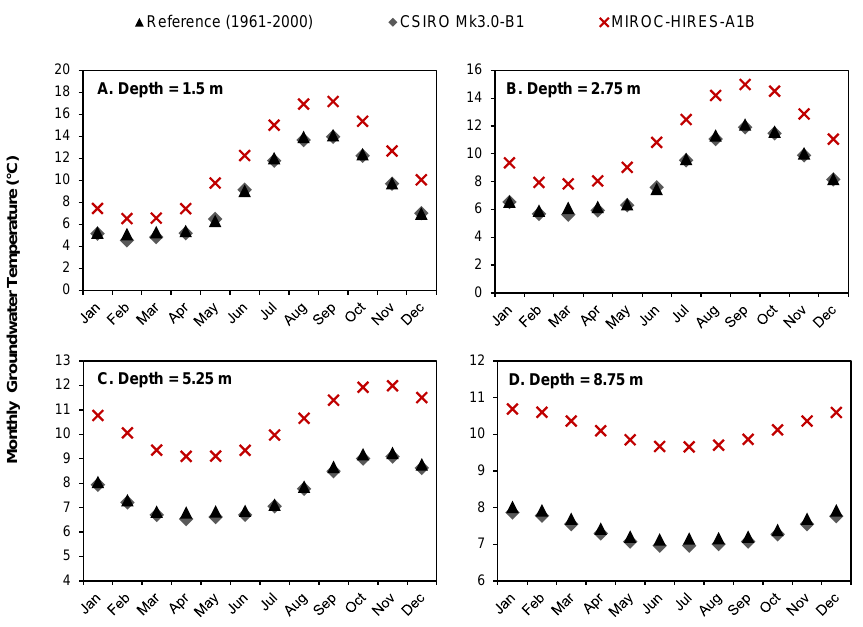
Fig. 11. Results from the empirical GST-groundwater temperature transfer function driven by the ForHyM2-produced GST temperature for the reference period and two projected climate scenarios. Of the seven climate scenarios, the CSIRO Mk3.0-B1 and the MIROC 3.2 HIRES- A1B climate scenarios consistently produced the lowest and highest monthly groundwater temperature data, respectively.